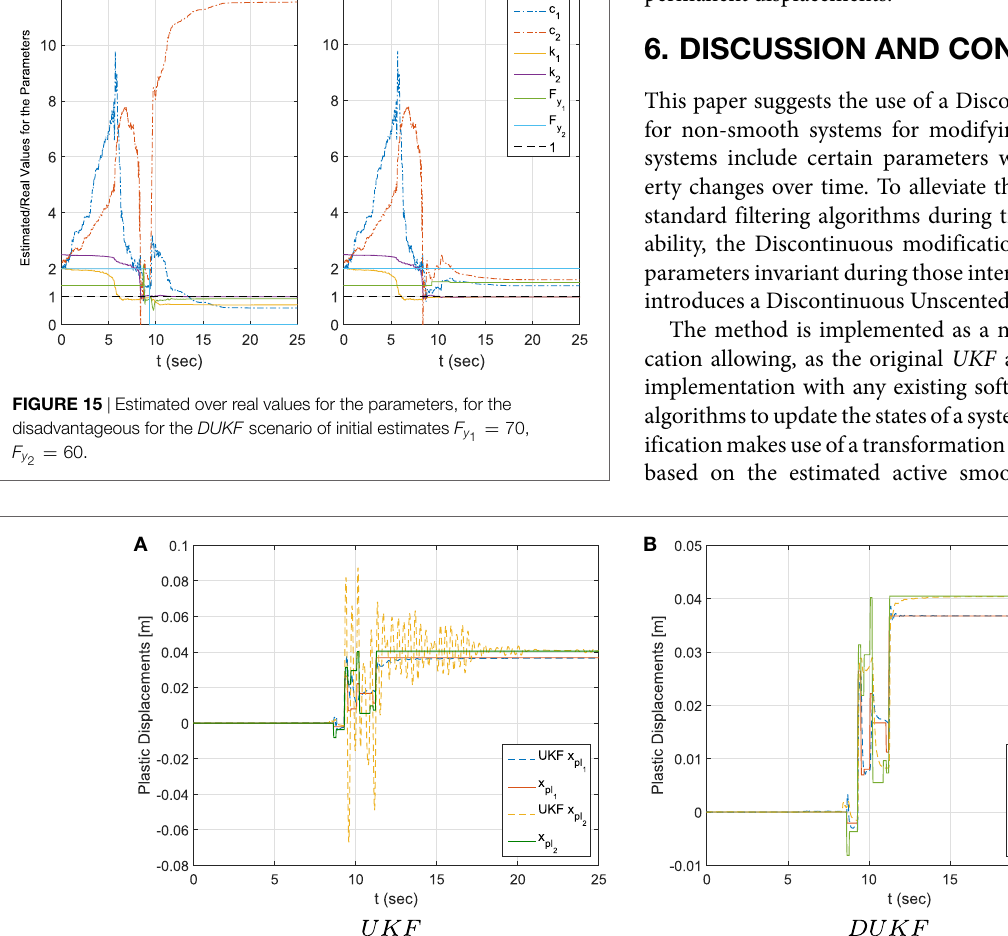
FIGURE 16 | Estimated versus real plastic displacements of the springs for (A) UKF and (B) DUKF , for the disadvantageous for the DUKF scenario of initial estimates = 70, F y = F y 1 2